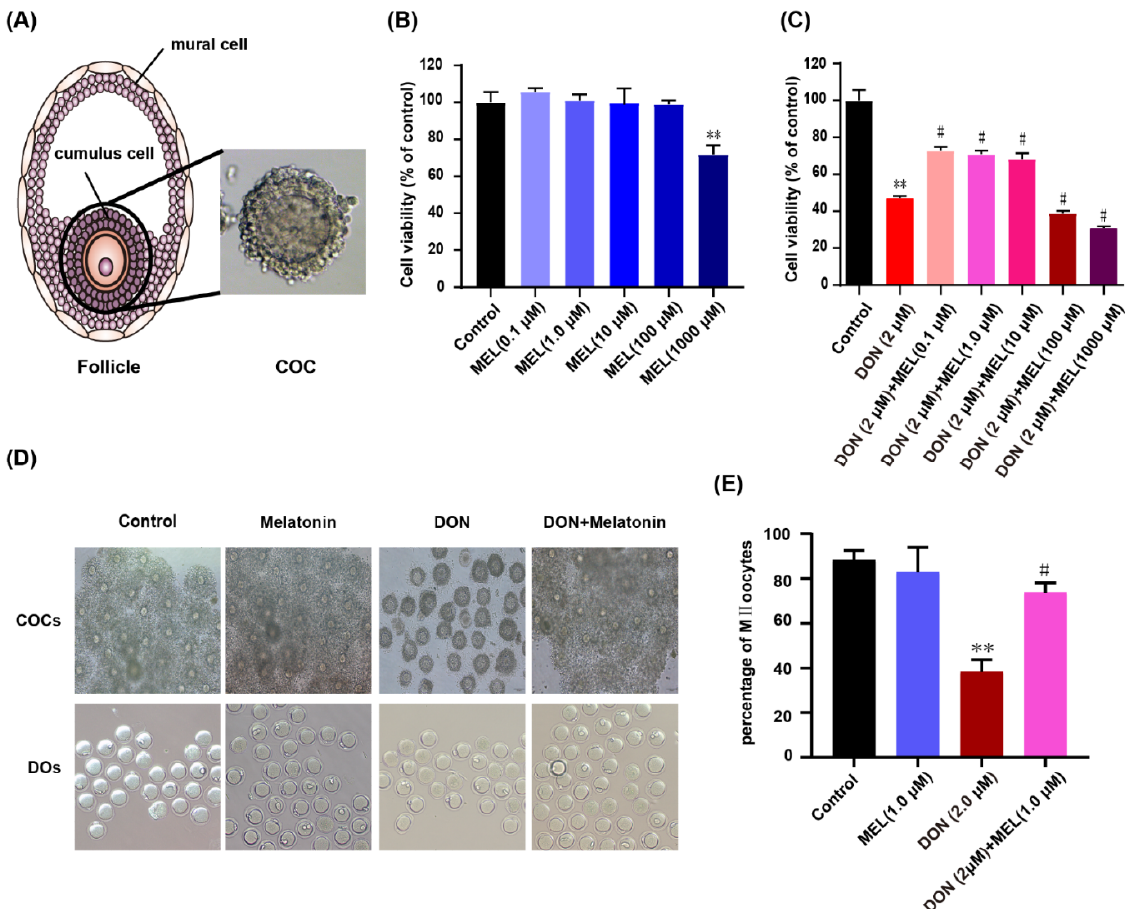
Figure 1. The effect of melatonin and DON on murine ovary GCs and oocytes. ( A ) The mode pattern of mammalian follicle and cumulus–oocyte complex (COC) (Magnification: 400×). ( B ) The effects of gradient concentration of melatonin on GCs Cell viability for 24 h. ( C ) The effects of combined treatment melatonin and DON on GCs cell viability for 24 h. Cell viability was determined using the CCK-8 assay. ( D ) Oocyte morphologies in the control, Melatonin-exposed, DON-exposed, and melatonin + DON groups. Scale bar: 100 µm. ( E ) The effects of melatonin on the rate of polar body extrusion in DON-exposed oocytes. The data are expressed as the means ± SEM. ** p < 0.05 compared with the control; # p < 0.05 compared with the DON group. The results showed that appropriate melatonin significantly inhibited DON-induced decreases in cell viability. MEL: melatonin.